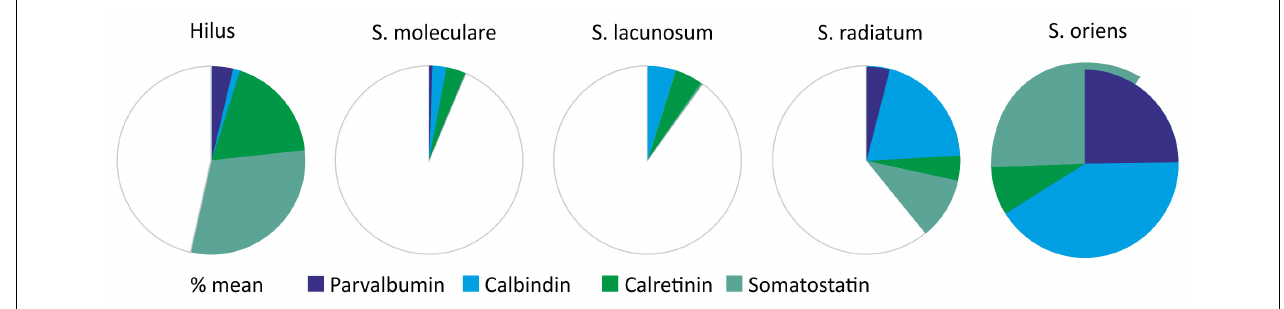
FIGURE 6 | In this Figure, the proportion of hAPP-positive hippocampal interneurons co-expressing parvalbumin, calbindin, calretinin, and somatostatin is summed up in individual hippocampal layers. In stratum moleculare and stratum lacunosum moleculare less than 10% of all hAPP-expressing neurons are immunoreactive for the four interneuron markers analyzed, whereas in stratum radiatum and DG hilus 40 to 50%, and in stratum oriens all hAPP-immunoreactive neurons are positive for these interneuron markers. Additionally, the contribution of individual interneuron types to the hAPP-expressing population varies considerably in hippocampal layers as indicated by the respective